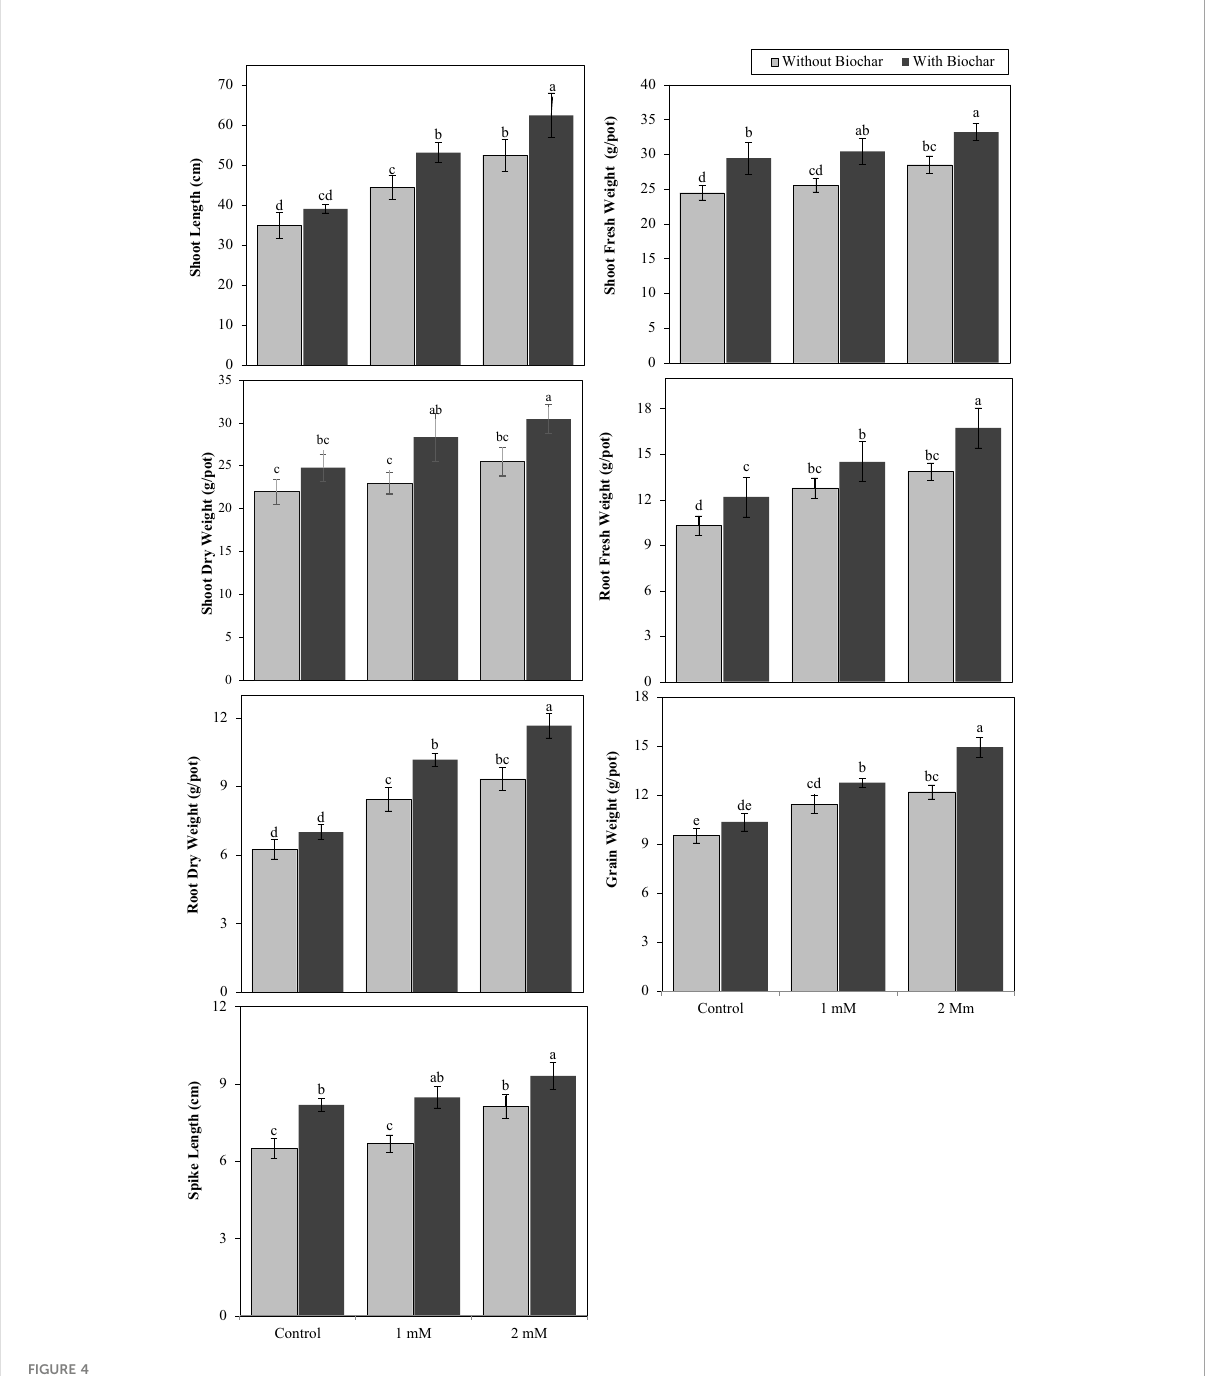
FIGURE 4 Data represent different levels of zinc – lysine (control 0, 1, 2 mM) with and without biochar on P in shoot, P in root, Fe in root, Fe in shoot, K in root, K in shoot, Na in root, Na in shoot, Zn in root, Zn in shoot, Zn in grain, and Na in grain of wheat plant showing means of replicates (n = 3) ± standard deviation. Different letters indicate signi fi cant differences by Tukey HSD test at p ≤